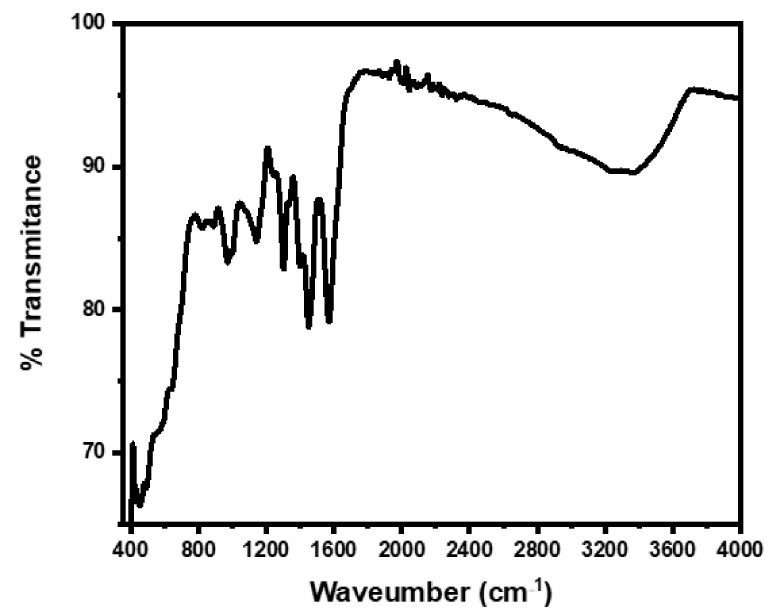
Figure 1. Fourier Transform Infra-Red (FT-IR) analysis spectrum of PANI@Al-SA MOFs nanocom- posite.